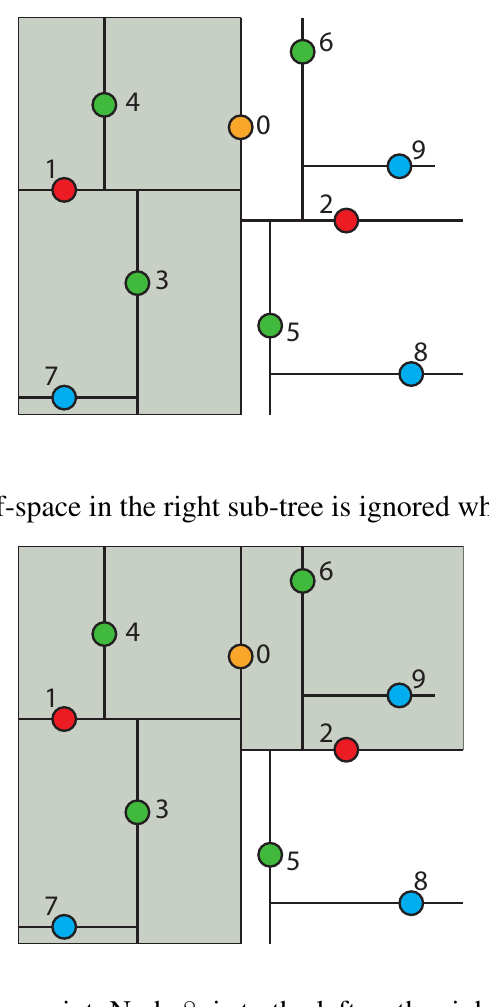
Figure 8. The left half-space of k-tree is ignored when searching Node 8.